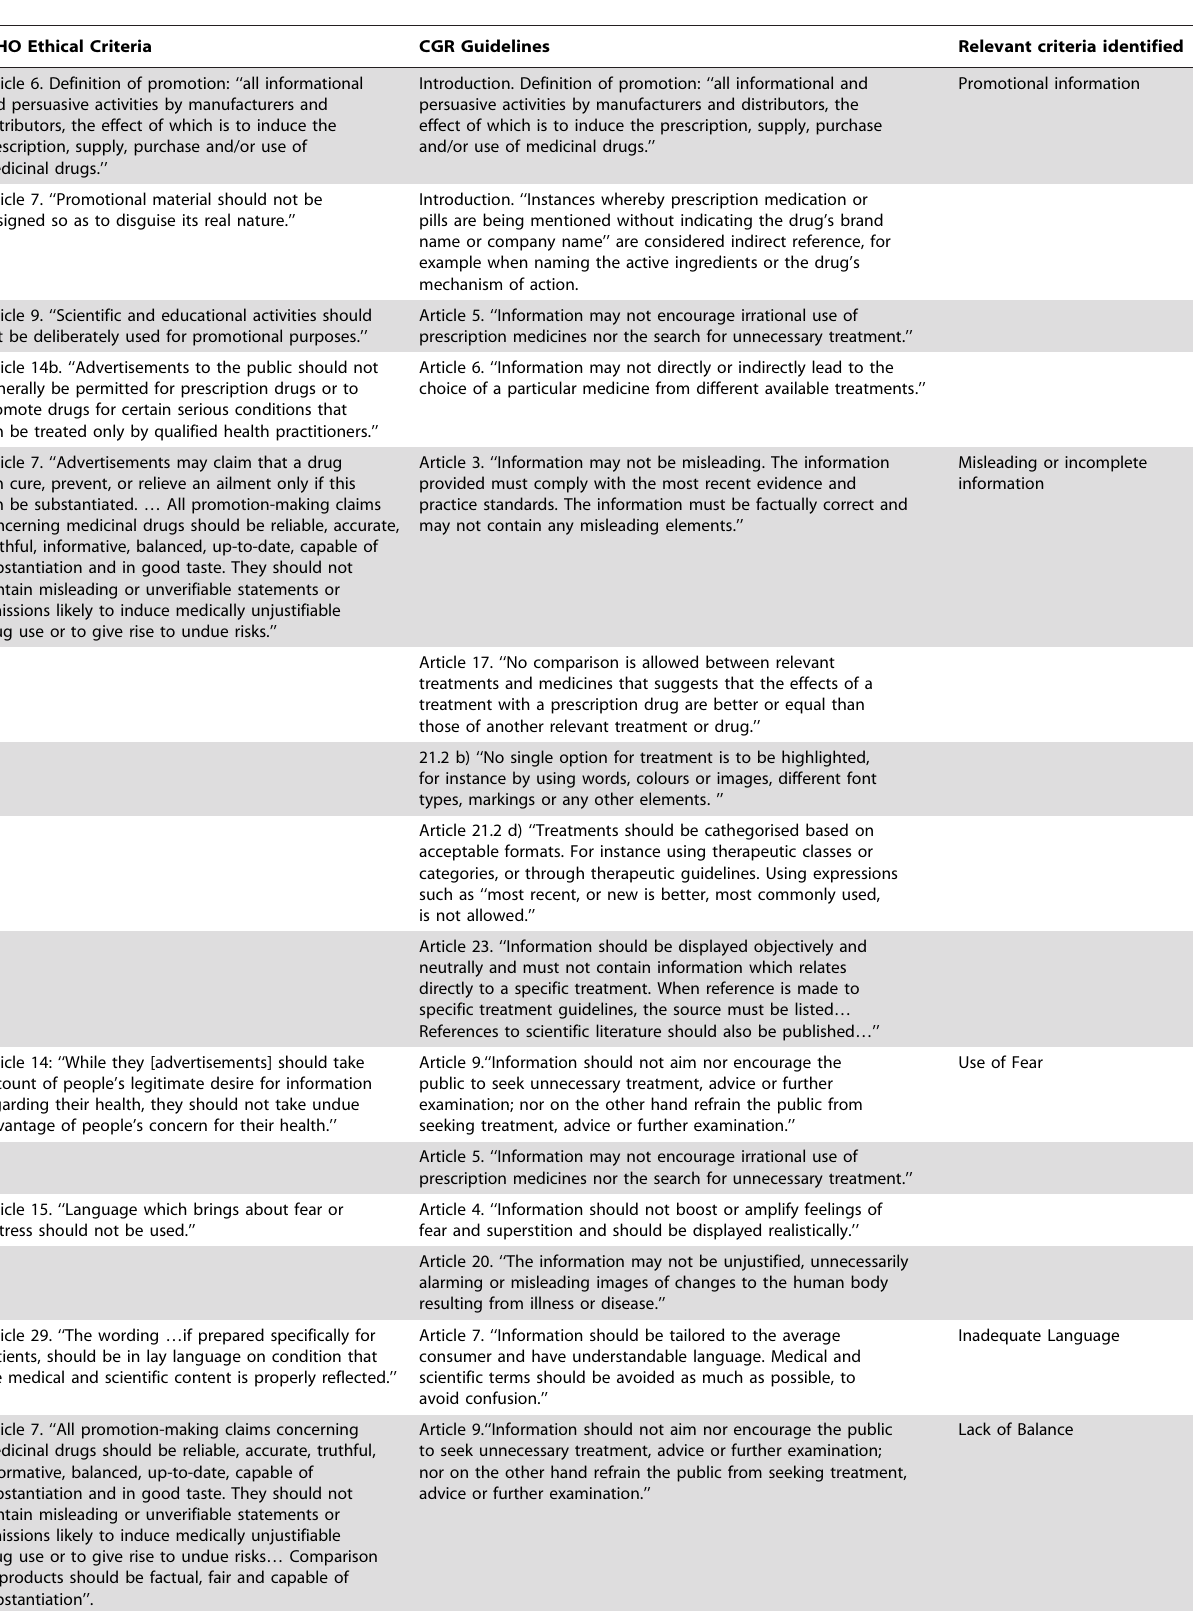
Table 1. Overlap between relevant provisions within the WHO Ethical Criteria for Medicinal Drug Promotion and the CGR Guidelines for provision of information on prescription